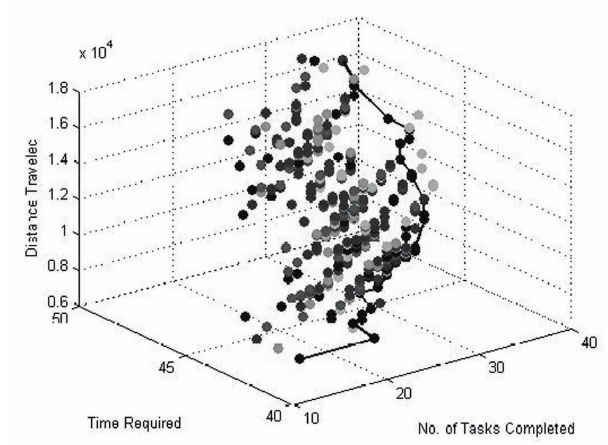
Figure 1. Pareto optimality curve: normal distribution.